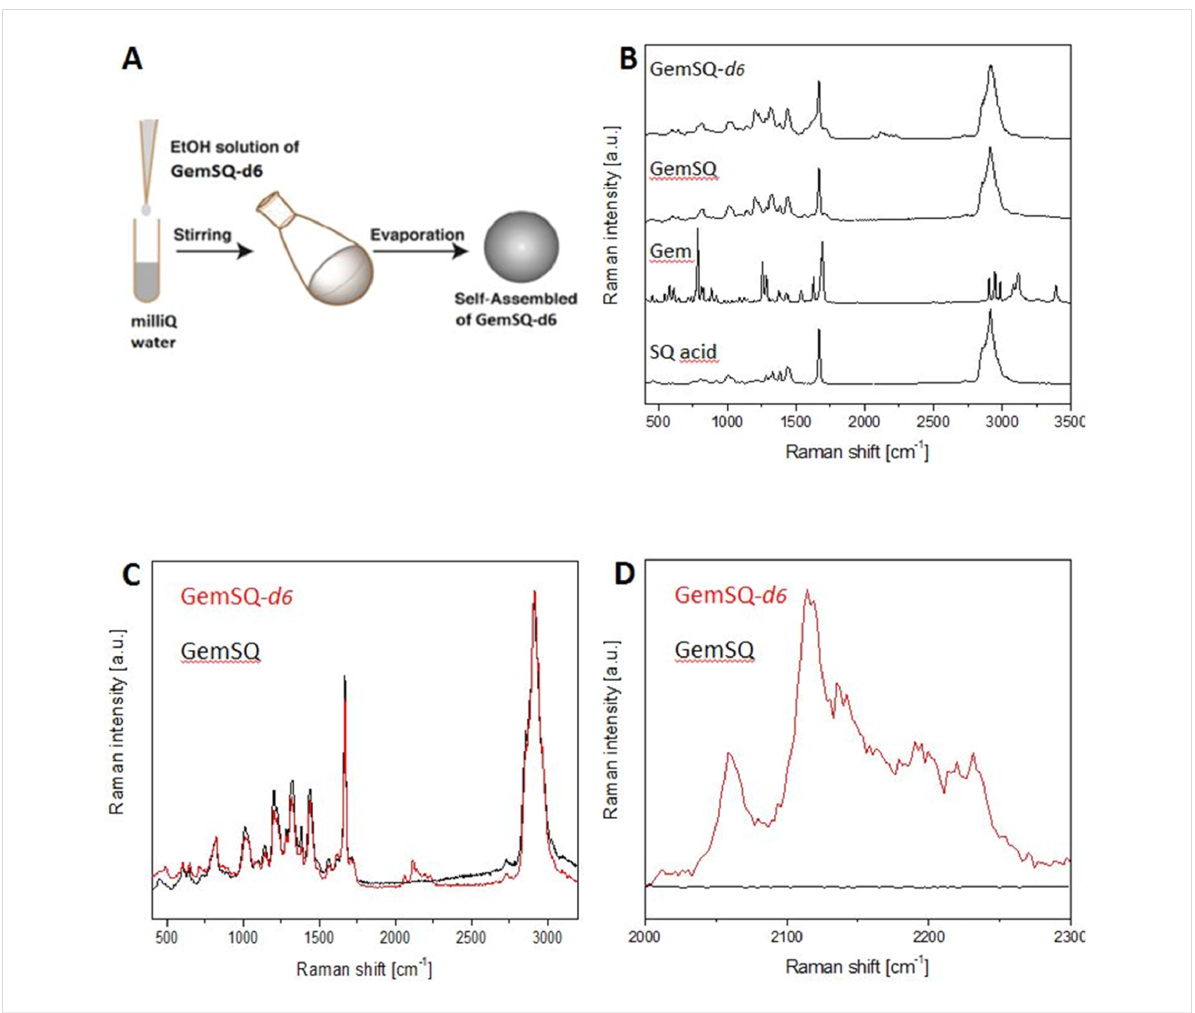
Figure 2: A) Sketch depicting the procedure of preparing the NAs. B) Single Raman spectra of GemSQ- d 6 NAs, GemSQ NAs, gemcitabine and squalenic acid, respectively. C) Single Raman spectra of deuterated GemSQ- d 6 NAs (red) and GemSQ NAs (black). D) Close-up showing the differ- ence between deuterated and non-deuterated